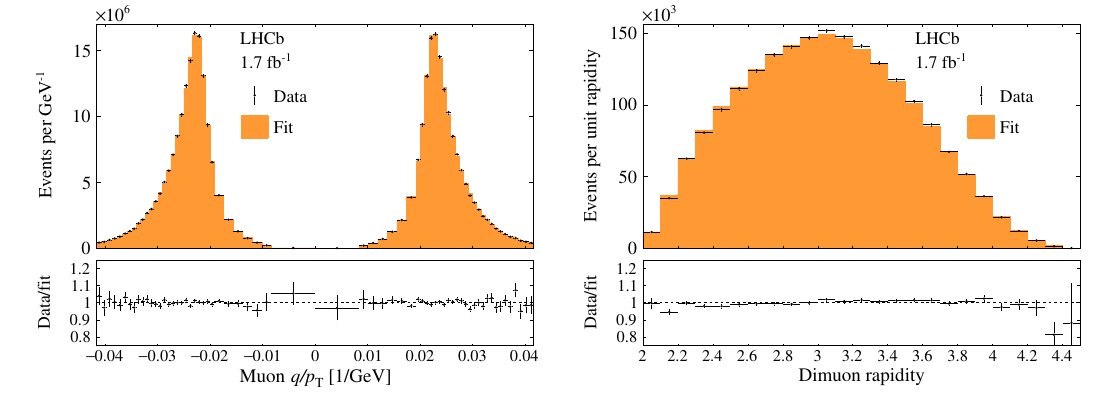
Figure 12 . Projections of the (left) q/p T and (right) rapidity distributions for the Z boson selection. A final state muon is only included in the q/p